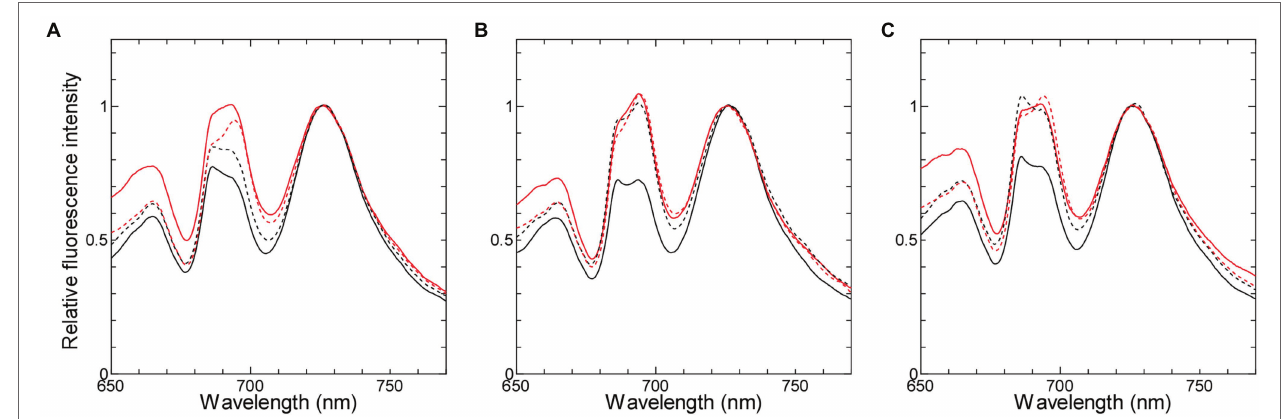
FIGURE 1 | 77 K chlorophyll fluorescence emission spectra with phycocyanin excitation at 625 nm in the wild-type strain (A) , Δ ndhF1 (B) , and Δ gnd (C) . Black solid line, dark-acclimated cells in the presence of 0.2 mM KCN; black dashed line, dark-adapted cells without any addition; red dashed line, growth light- acclimated cells; and red solid line, high light-acclimated cells in the presence of 10 μ M DCMU. Each fluorescence spectrum was normalized at the PSI fluorescence peak at 725 nm. The averaged spectra of three independent cultures are presented except for the spectrum of the growth light-acclimated Δ ndhF1 cells (average of two independent